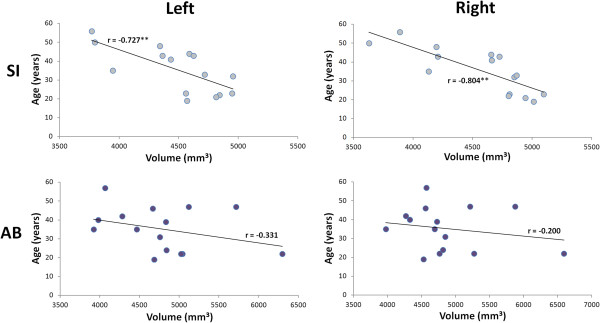
Effect of age on caudate volume. Illustrated here are the correlations between the age of the subjects and the caudate nucleus volume in the sighted (SI – top panel) and blind (AB: all blind subjects combined – bottom panel) subjects respectively. While there is a significant negative correlation between both measures in the sighted, indicating an age-related decline in caudate volume, the correlation in the blind (both CB and LB combined) is much weaker and did not reach statistical significance.